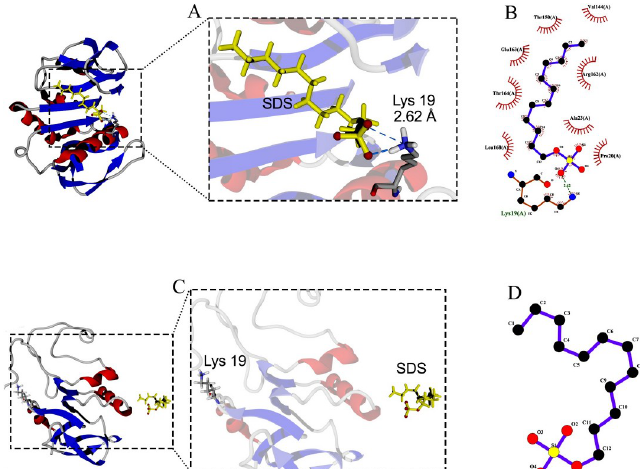
Fig 6. Docking of protease 1147 and SDS ligand. (A) Docked protease 1147-SDS complex indicated (before MD simulation), and (B) its 2-D display indicated an interaction between Lys 19 of protease 1147 with oxygen atom at position 4. (C) Docked protease 1147-SDS complex (after MD simulation), and (D) its 2-D display indicated loss of the interaction. The results of docking runs were completely identical. https://doi.org/10.1371/journal.pone.0234958.g006 complex with Tween 20 compared to the protease 1147 alone (Fig 7B). The radius of gyration (Rg) decreased in the protease 1147-Tween 20 complex, which indicates higher protease stabil- ity when it is complexed with Tween 20 (Fig 7C). The MD simulation of protease 1147 at 100˚C indicated protease instability after 20 ns and loss of structure after 40 ns.